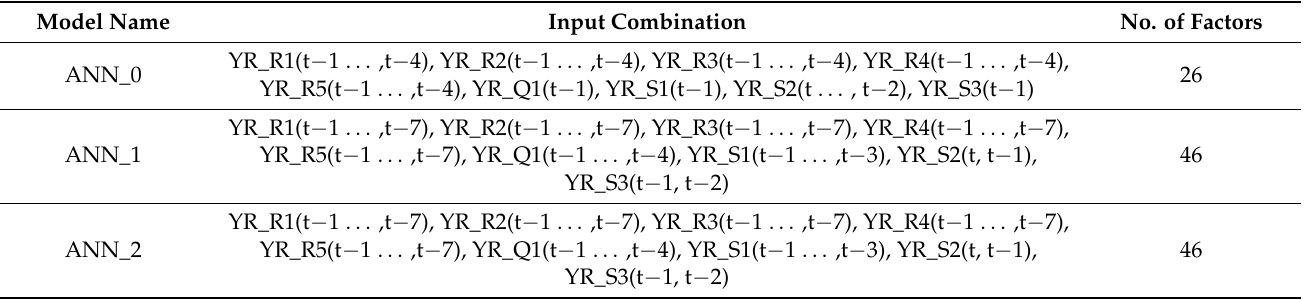
Table 4. ANN models and their input